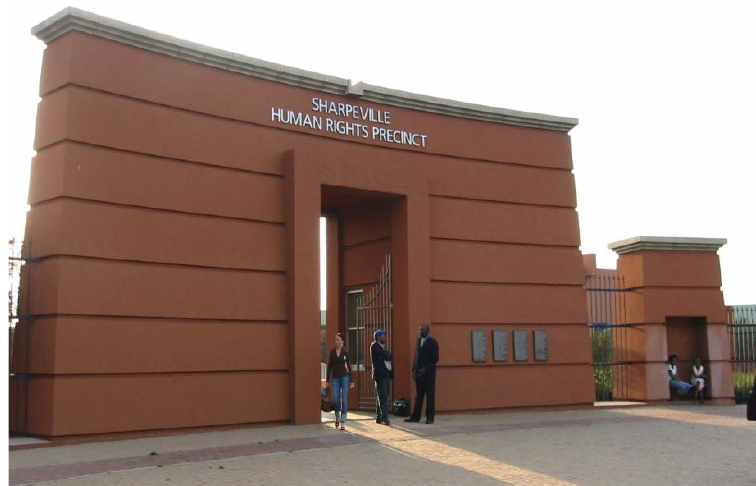
Figure 10. Entrance to the memorial garden at the Sharpeville Human Rights Precinct and Exhibition Centre (author’s